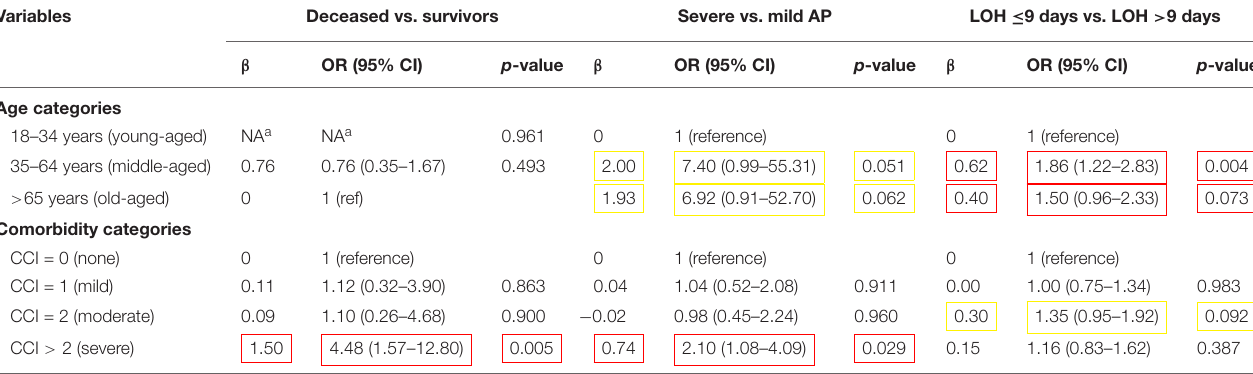
TABLE 2 | Joint effect of aging and comorbidities on the outcomes of AP. Variables Deceased vs. survivors